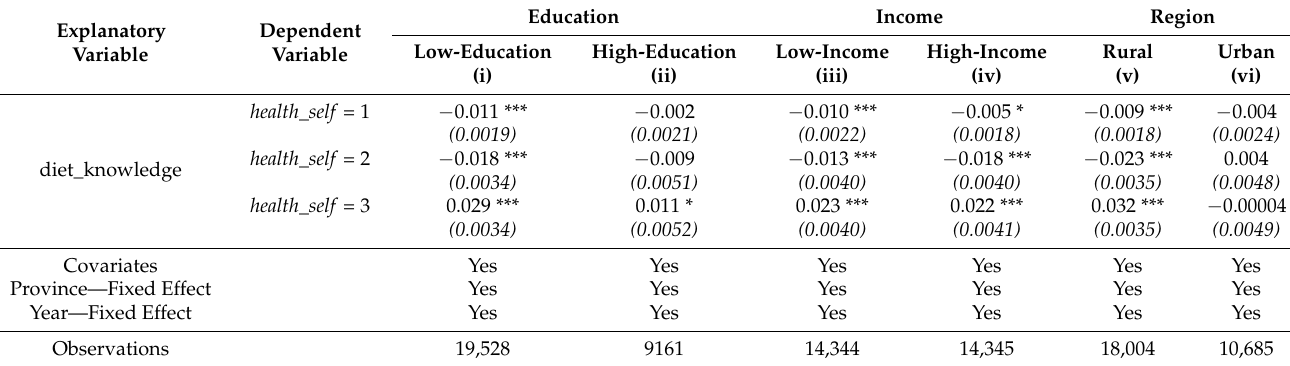
Table 6. Estimation results of the heterogeneous marginal effects of dietary knowledge on health based on the generalized ordinal logit